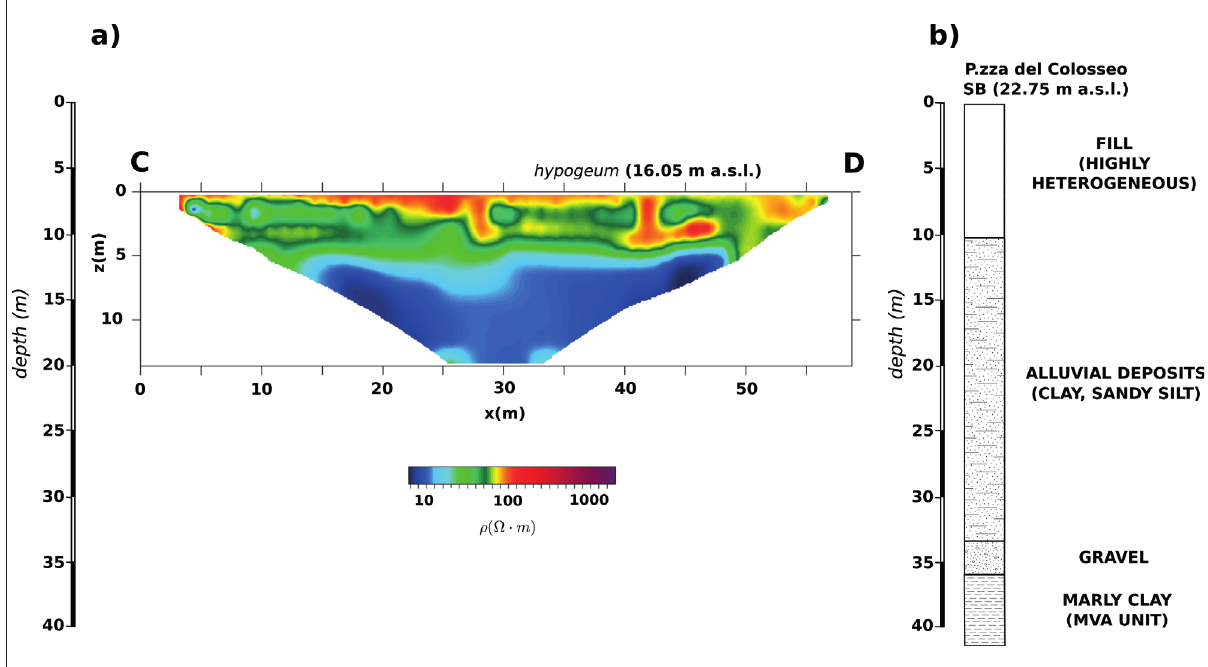
Figure 6. (a) Results of the ERT line CD. (b) Stratigraphy of borehole SB.